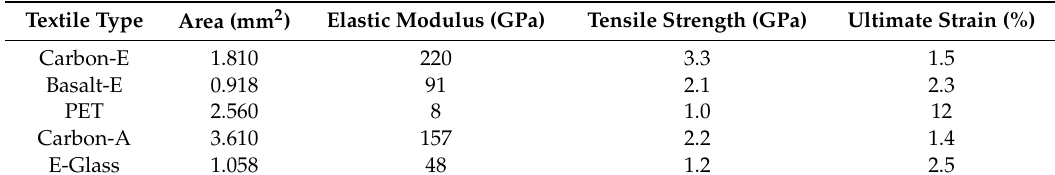
Table 5. Mechanical properties of the textiles.